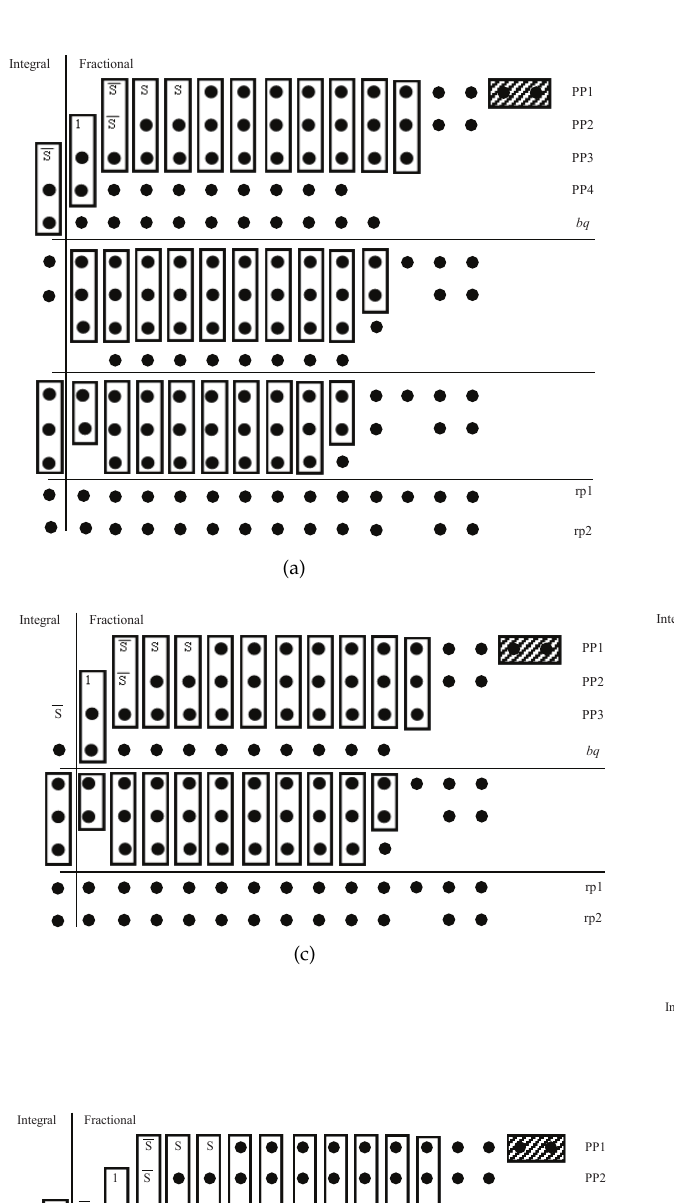
Figure 9. Partial products with sign extensions and bq in the implementations for 2 f ( a ), log (cid:112) ( b ), 1 ( c ), 1 √ ( d ), 1 + f ( e ) and multiple functions with the reuse of computing resources ( f ). 1 + f 1 + f Rectangular boxes indicate full or half adders. Rectangular boxes with slashes indicate that the bits are abandoned. pp1 to pp5 represent the partial products of the Booth multiplier. S is the sign bit of the partial